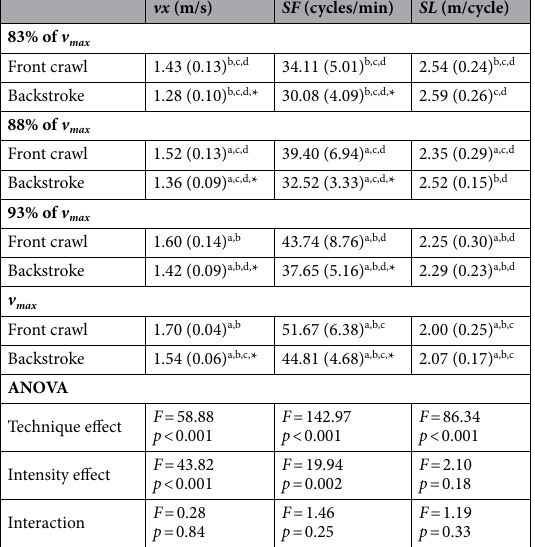
Table 1. Descriptive statistics and results from ANOVA test in swimming velocity, stroke frequency, and stroke length in front crawl and backstroke. vx mean horizontal one-cycle velocity, SF stroke frequency, SL stroke length, v max maximal horizontal velocity a; b; c; and d, difference from 83% of v max ; 88% of v max ; 93% of v max ; and v max , respectively; *Difference from front crawl at the comparable